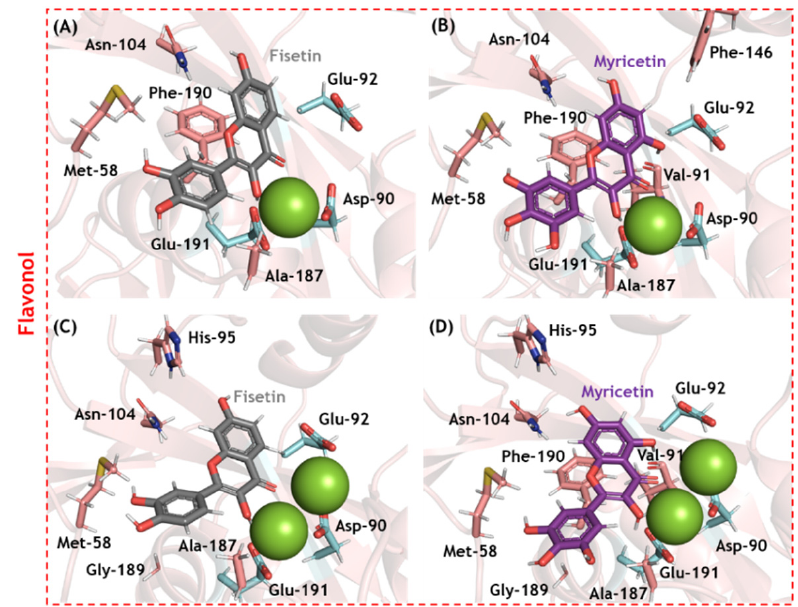
Figure 5. The main amino acid residues from SARS-CoV-2 nsp14 ExoN that interact with ( A ) fisetin and ( B ) myricetin in the presence of one Mg(II) ion, and ( C ) fisetin and ( D ) myricetin in the presence of two Mg(II) ions. The interactive and catalytic amino acid residues are in beige and cyan, respectively; fisetin and myricetin are in gray and purple, respectively. Mg(II) ions are represented as green spheres. Hydrogen, oxygen, and nitrogen are shown in white, red, and dark blue, respectively. Table 3. The main amino acid residues that interact with fisetin and myricetin in the catalytic pocket of SARS-CoV-2 nsp14 ExoN in the presence of one or two Mg(II) ions. Compound Amino Acid Residue Interaction